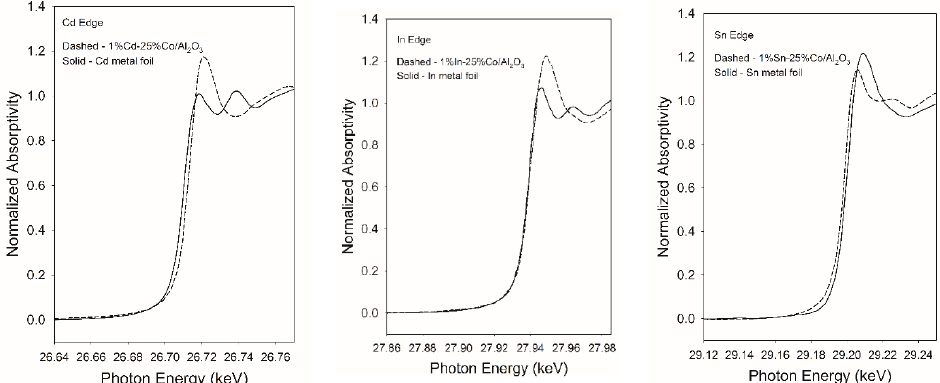
Figure 4. XANES spectra of 1%Cd-25%Co / Al 2 O 3 ( left ), 1%In-25%Co / Al 2 O 3 ( middle ) and 1%Sn-